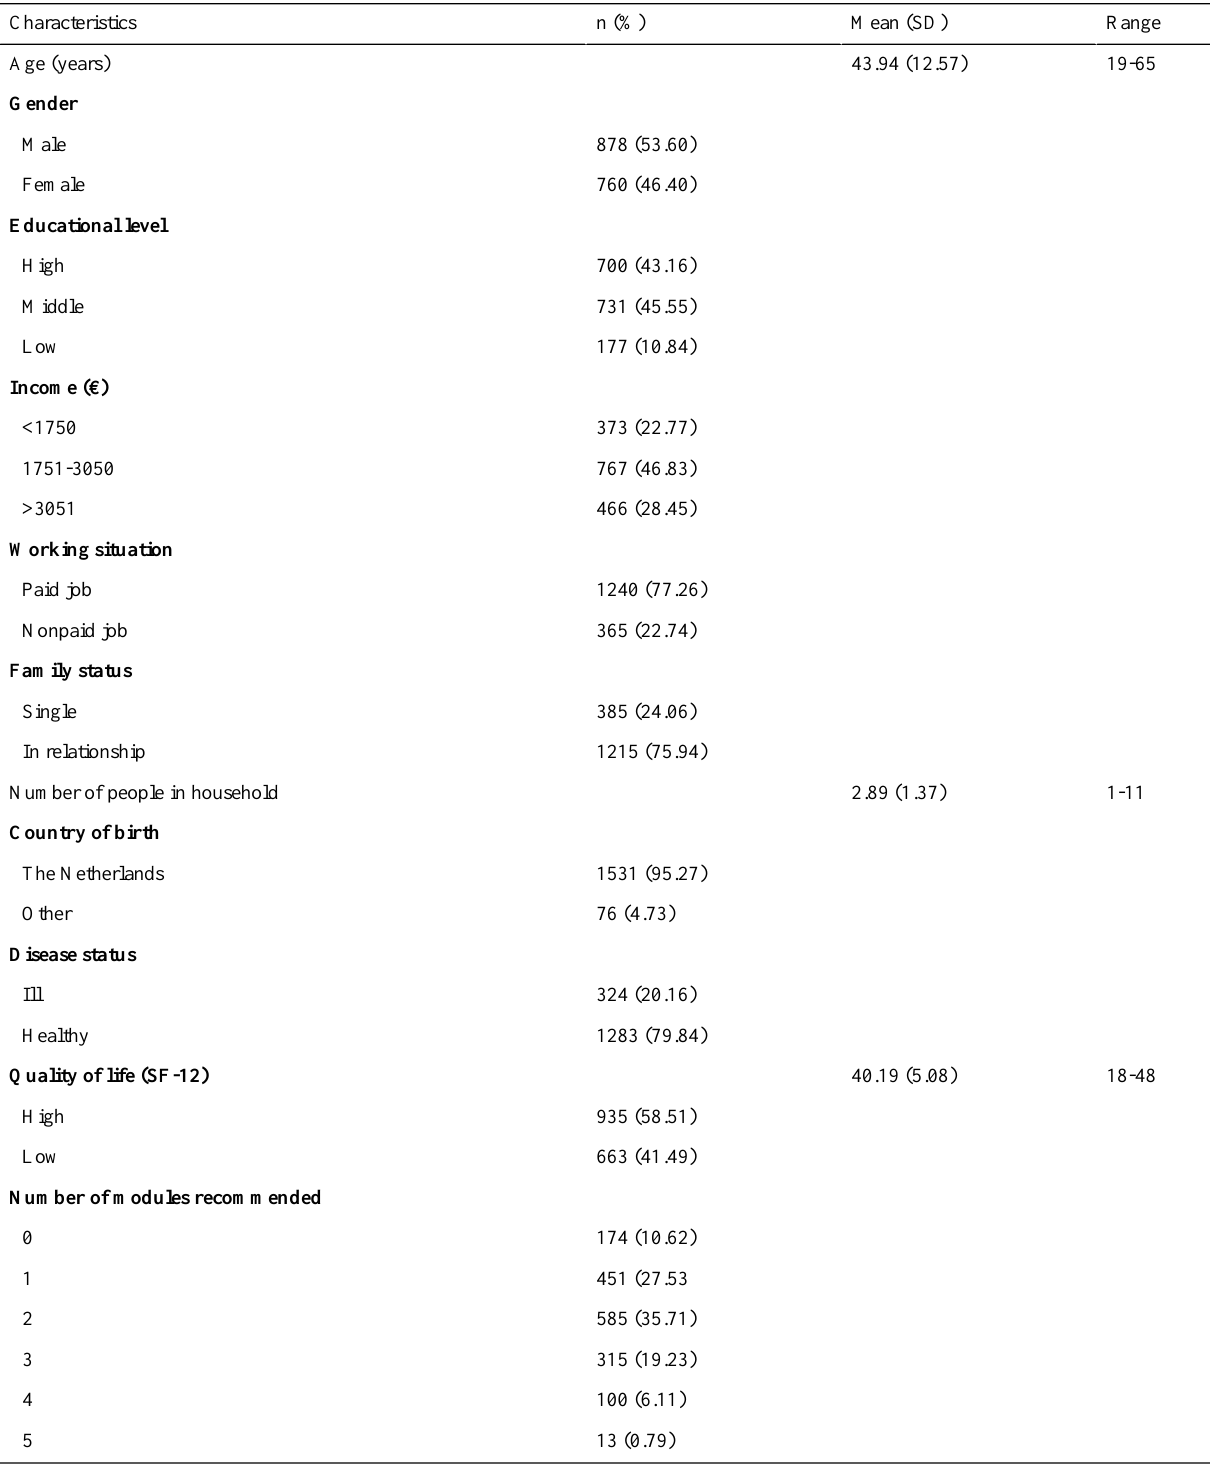
Table 1. Sample characteristics